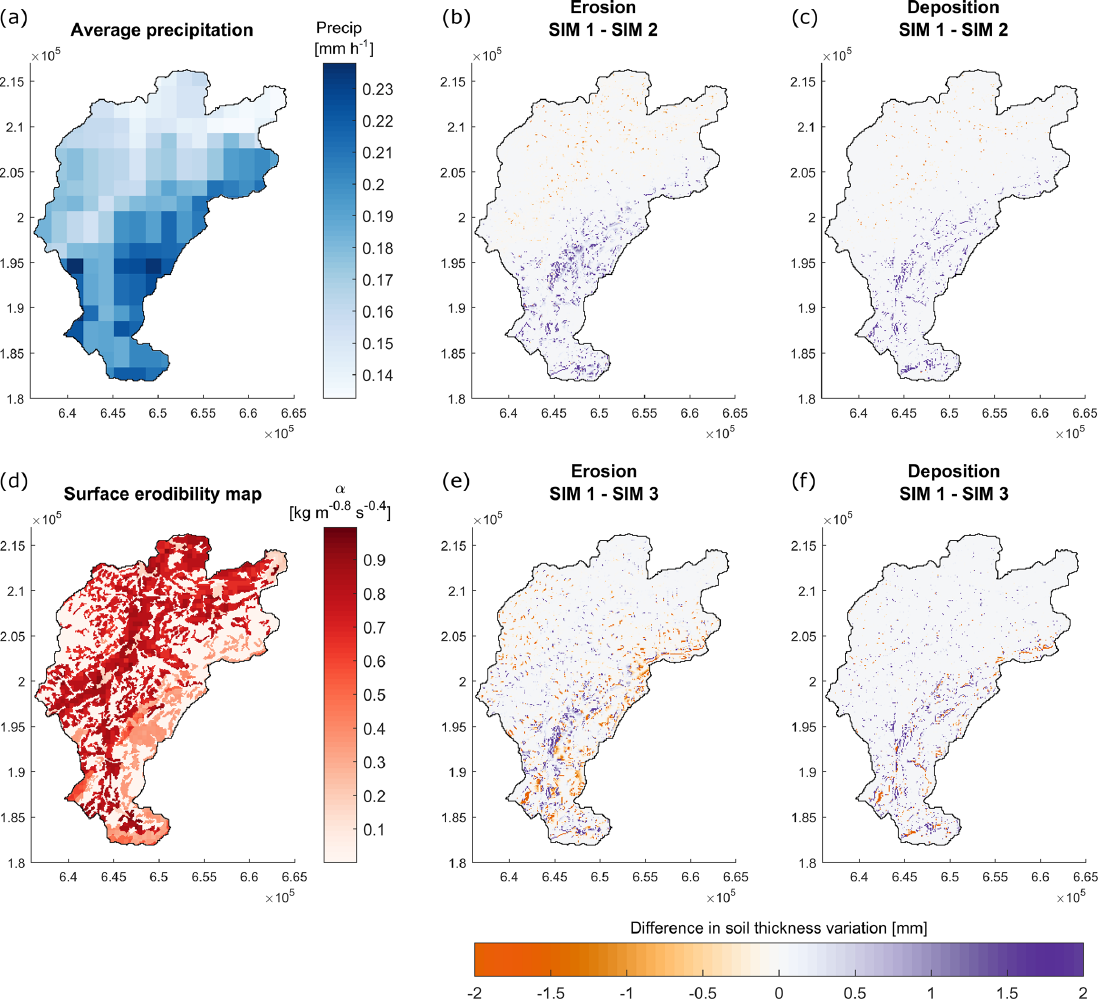
Figure 7. (a) Average spatial distribution of precipitation intensity for the period 2004–2016; (b, c) difference between erosion/deposition generated by variable and uniform rainfall in 13 years; (d) spatial distribution of calibrated surface erodibility α ; (e, f) difference between erosion/deposition generated by variable and uniform surface erodibility in 13 years. A positive value indicates more erosion/less deposition by variable precipitation or surface erodibility, and a negative value indicates less erosion/more